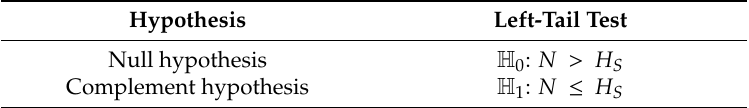
Table 7. Definition of the null and complement hypothesis for left-tailed